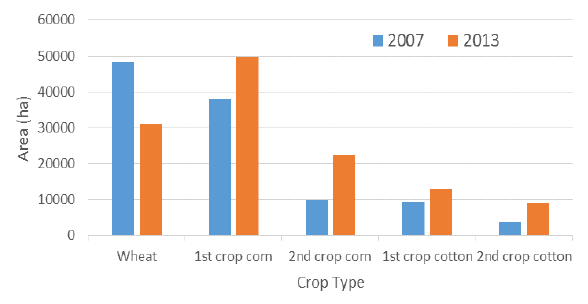
Figure 5. Areal difference of the wheat, corn and cotton areas between 2007 and